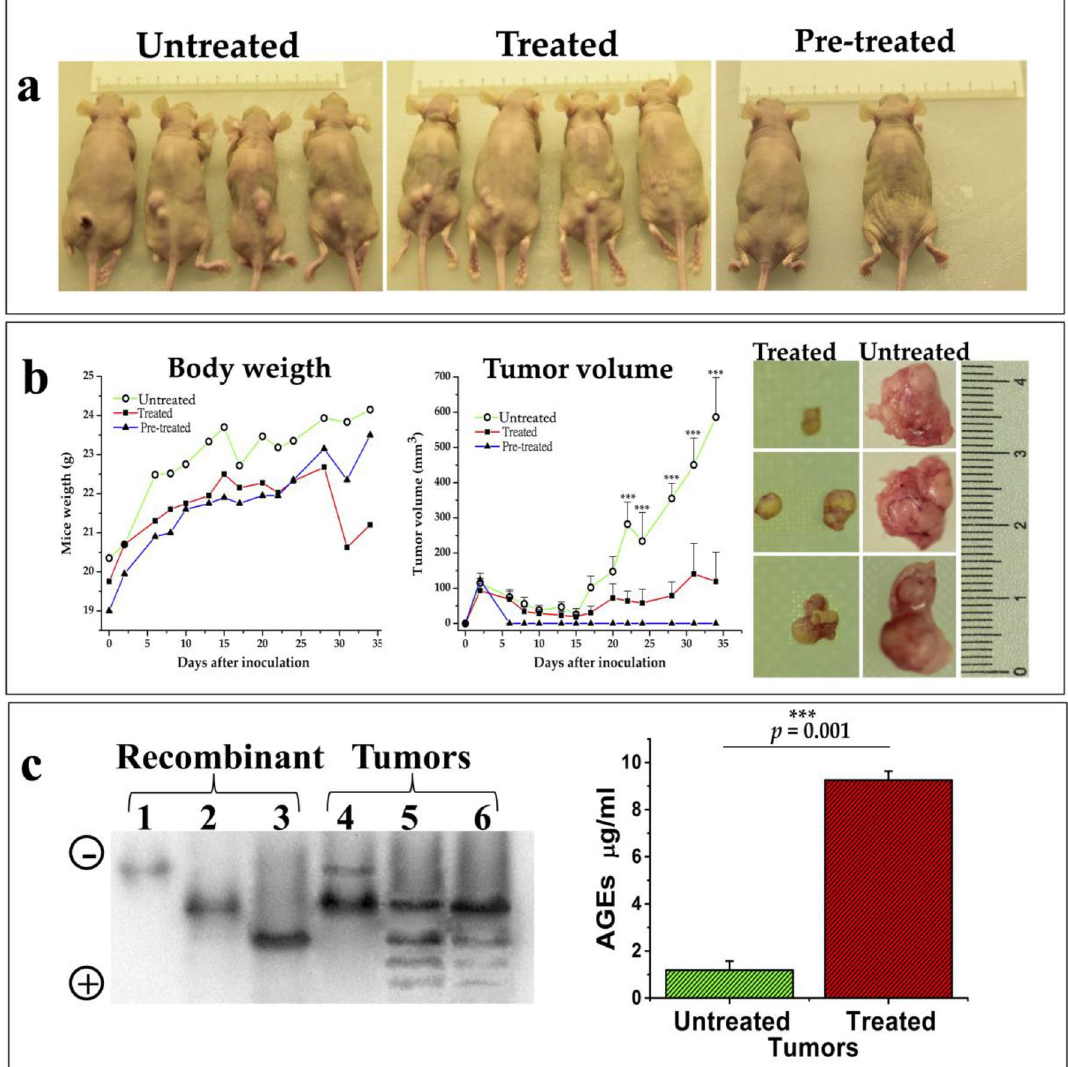
Figure 5. Xenograft rodent model to analyze deamidated HsTIM accumulation in tumors and the effect of rabeprazole. ( a ) Representative images of mice from the different experimental groups. Mice were subcutaneously inoculated with MDA-MB-231 cells (20 × 10 6 cells); 7 days after cell implantation, placebo (PBS) (untreated group) or rabeprazole (50 mg/kg of weight) (treated group) were administered three times a week by intraperitoneal injection. Also, a group of mice implanted with breast cancer cells previously incubated for 24 h with 1 mM rabeprazole (pre-treated) was included. ( b ) Changes in body weight and tumor volume were noted throughout the experiment (graphs). Representative images of tumors from treated and untreated mice at the end of the experiment. ( c ) Western blot of the total proteins extracted from tumors and analyzed by nPAGE shows deamidated HsTIM and its acidic isoforms produced under the treatment with rabeprazole. Lanes 1–3, recombinant proteins of the nondeamidated (lane 1), once deamidated (lane 2), and twice deamidated HsTIM (lane 3). Lanes 4–6, the acidic isoforms of HsTIM from the xenograft tumors of untreated mice (lane 4) and two different tumors from treated mice (lanes 5 and 6). The polarity of the gel is indicated on the left side. The graph shows the significantly increased production of AGEs in tumors treated with rabeprazole (red bar) compared to untreated tumors (green bar). Differences among groups were assessed with one-way ANOVA and Tukey’s test with p-value = 0.001 ***. The full-length blot of panel “ c ” is shown in Suppl. Fig. but not in their normal counterparts was demonstrated with a selective cleavage method and nPAGE (Fig. 2a,b, respectively). Second, deamidated HsTIM was shown to accumulate in cancer cells, as demonstrated by the identification of the corresponding acidic isoform (Fig. 2b). Third, we showed the role of deamidated HsTIM in cancer cell-specific cell death induced by rabeprazole and auranofin (Fig. 2c). The selective inhibition of deamidated HsTIM, de novo generation of acidic isoforms, death of the cancer cells, and inhibition of tumor growth in vivo support this.